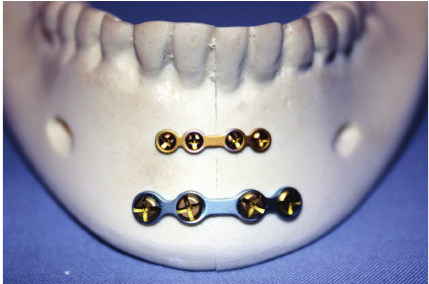
Figure 4: Ladder plate plus spanning plate (SP2).